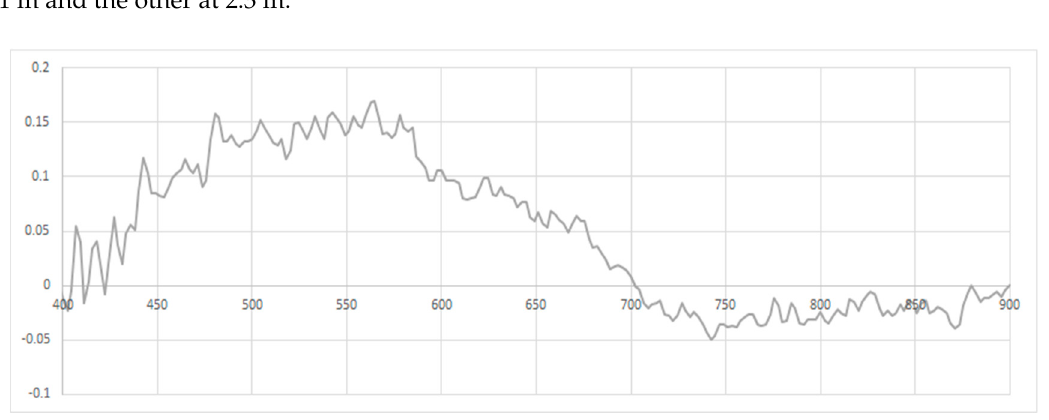
Figure 7. Spectral variance between massive Porites coral samples with level 4 bleaching at depths of 1 m and 2.3 m.